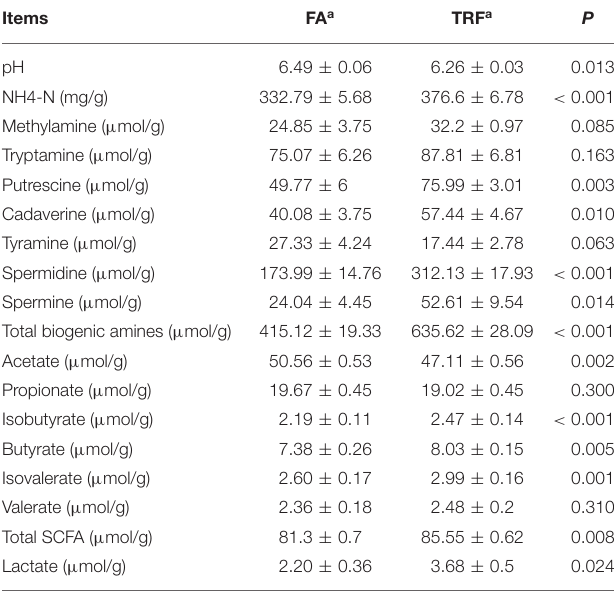
TABLE 1 | The pH value and concentrations of lactic acid, NH4-N, biogenic amines, and SCFAs in colonic digesta of growing pigs.